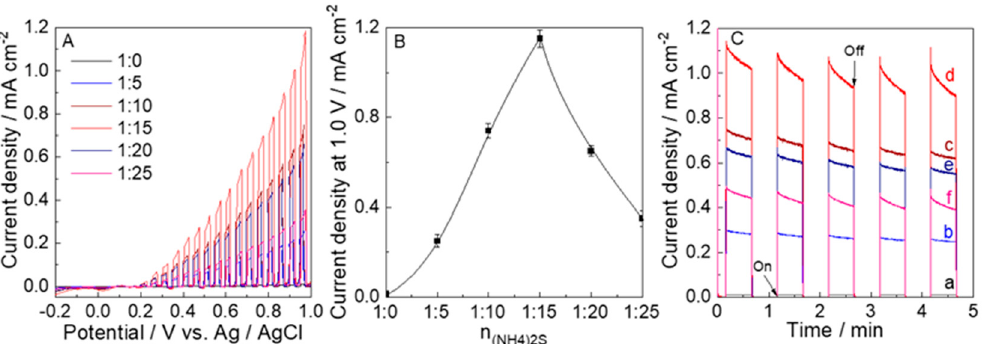
Figure 7. ( A ) Linear sweep voltammograms (LSV), ( B ) the plots of photocurrent density versus the addition of (NH 4 ) 2 S, and ( C ) time course of the photocurrent at 0.68 V vs. Ag/AgCl (1.23 V vs. RHE) of the (a) WO 3 − 0, (b) WO 3 − 5, (c) WO 3 − 10, (d) WO 3 − 15, (e) WO 3 − 20, and (f) WO 3 − 25 electrodes with visible-light irradiation chopped in a 0.1 M phosphate buffer solution of pH 6.0 with visible-light irradiation ( λ > 450 nm, 100 mW cm − 2 ).